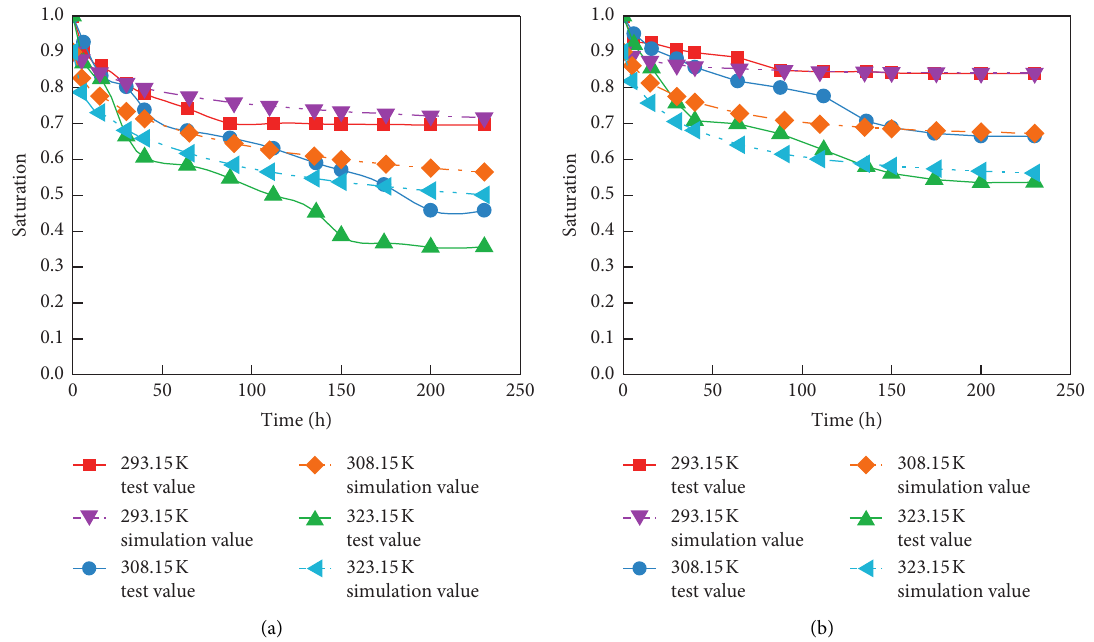
Figure 8: Simulated and experimental results of moisture desorption: (a) 10% RH and (b) 35% RH.